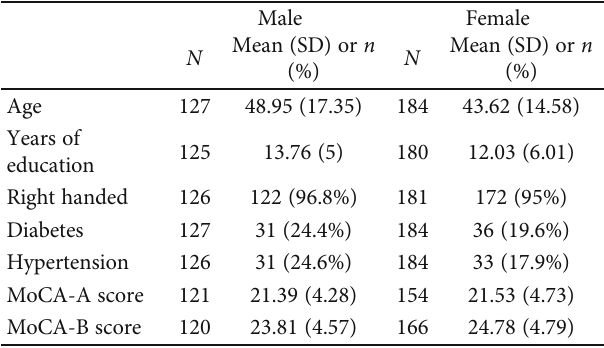
Table 1: Mean (SD) are provided for age, years of education, and MoCA scores. The remaining variables are numbers